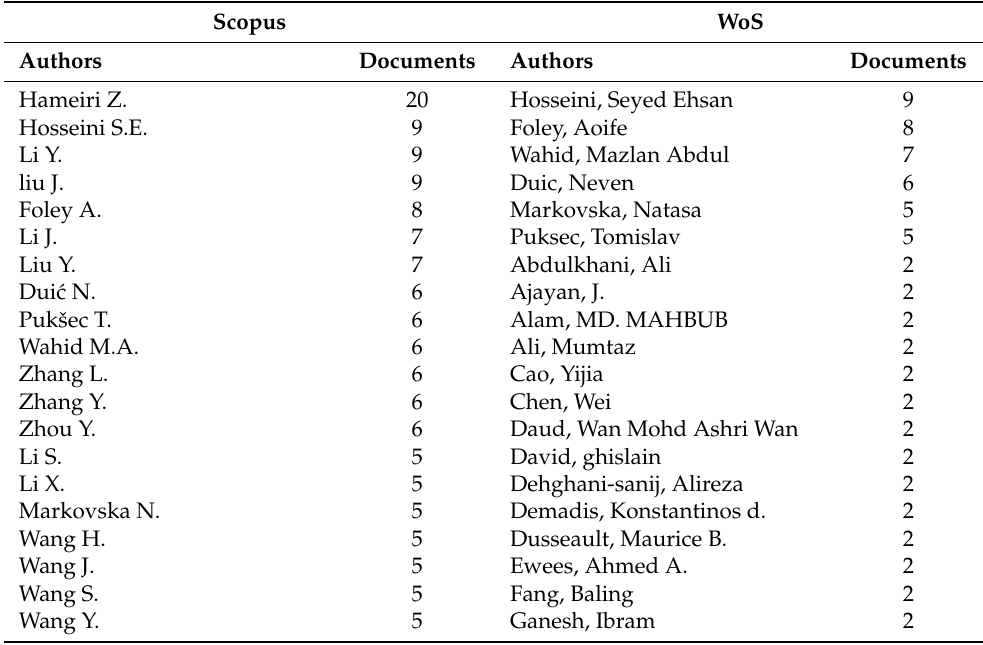
Table 1. Top-20 networked authors from Scopus and WoS databases for bibliographic coupling links.